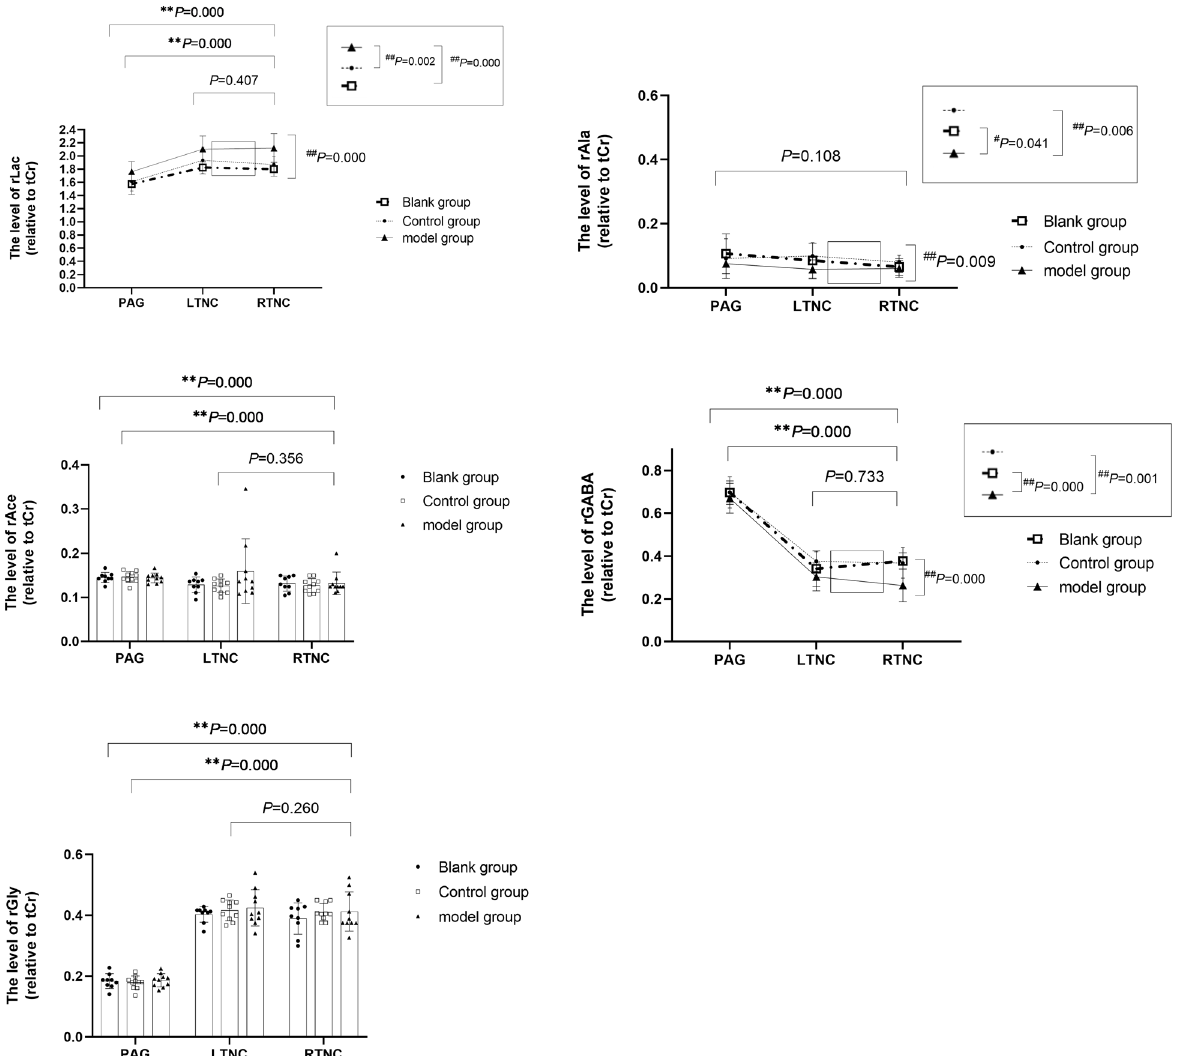
Fig. 3 Comparison of relative concentration of total brain metabolites in different parts. Compared with RTNC, * denotes P < 0.05, ** denotes P < 0.01; Compared with the model group, # indicates P < 0.05, and ## indicates P < 0.01. There were no significant differences in rLac, rAla, rAce, rGABA and rGly between LTNC and RTNC; There were significant differences in rLac, rAce, rGABA and rGly between PAG and RTNC which showed the rLac and rGly of PAG were lower than those of RTNC while the rAce and rGABA of PAG were higher than those of RTNC. The rLac, rAla and rGABA were statistically different among the groups (PAG, LTNC and RTNC), indicating the rAla and rGABA in the model group were lower than those in the control group and the blank group, when the rLac in the model group were higher than those in the control group and the blank